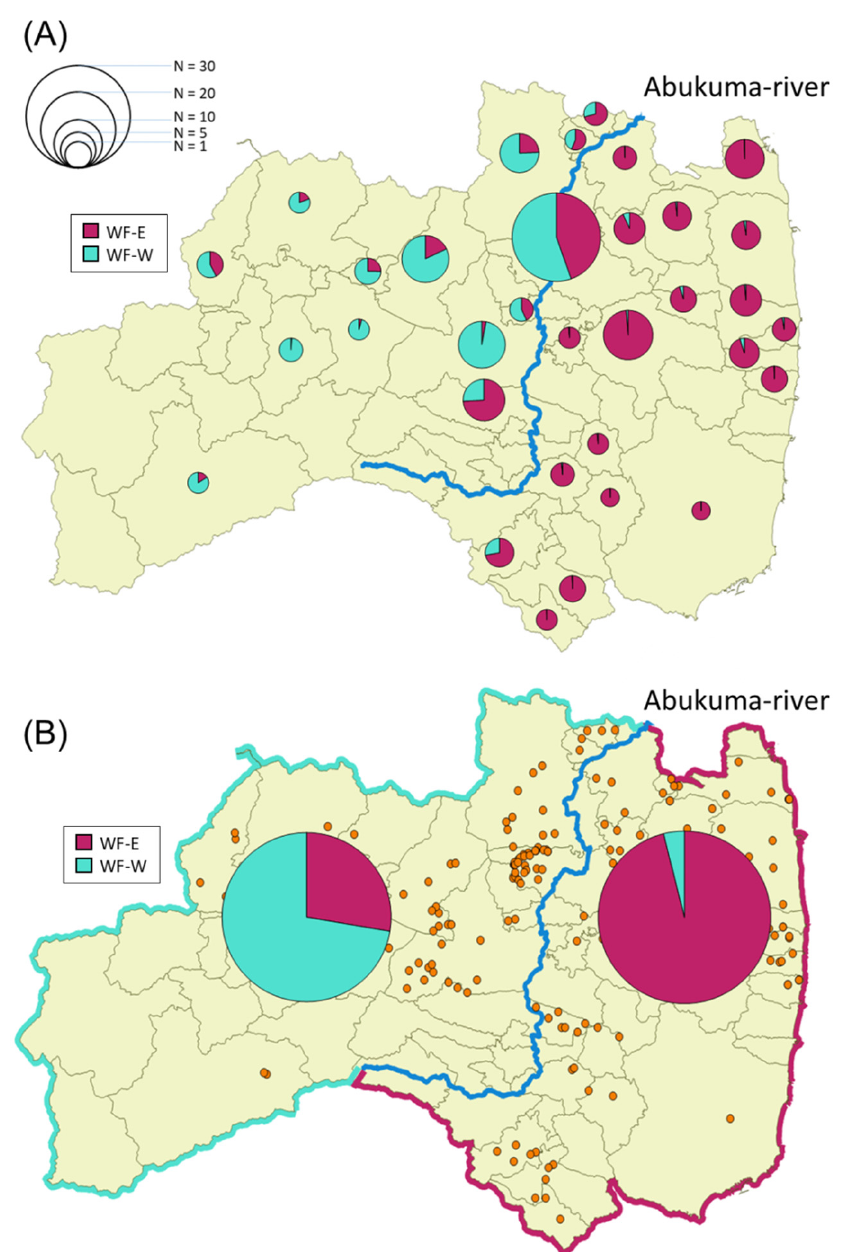
Figure 3. Sample number and detection rate (in percentage) of clusters WF-E and WF-W in each city/town/village ( A ) in eastern and western Abukuma River ( B ). The detection rate of clusters WF-E and WF-W was based on the results of STRUCTURE analysis ( K = 2, Figure 2). The size of the circle in the graphs corresponds to the number of samples. Sampling points of wild boars are shown in orange dots.